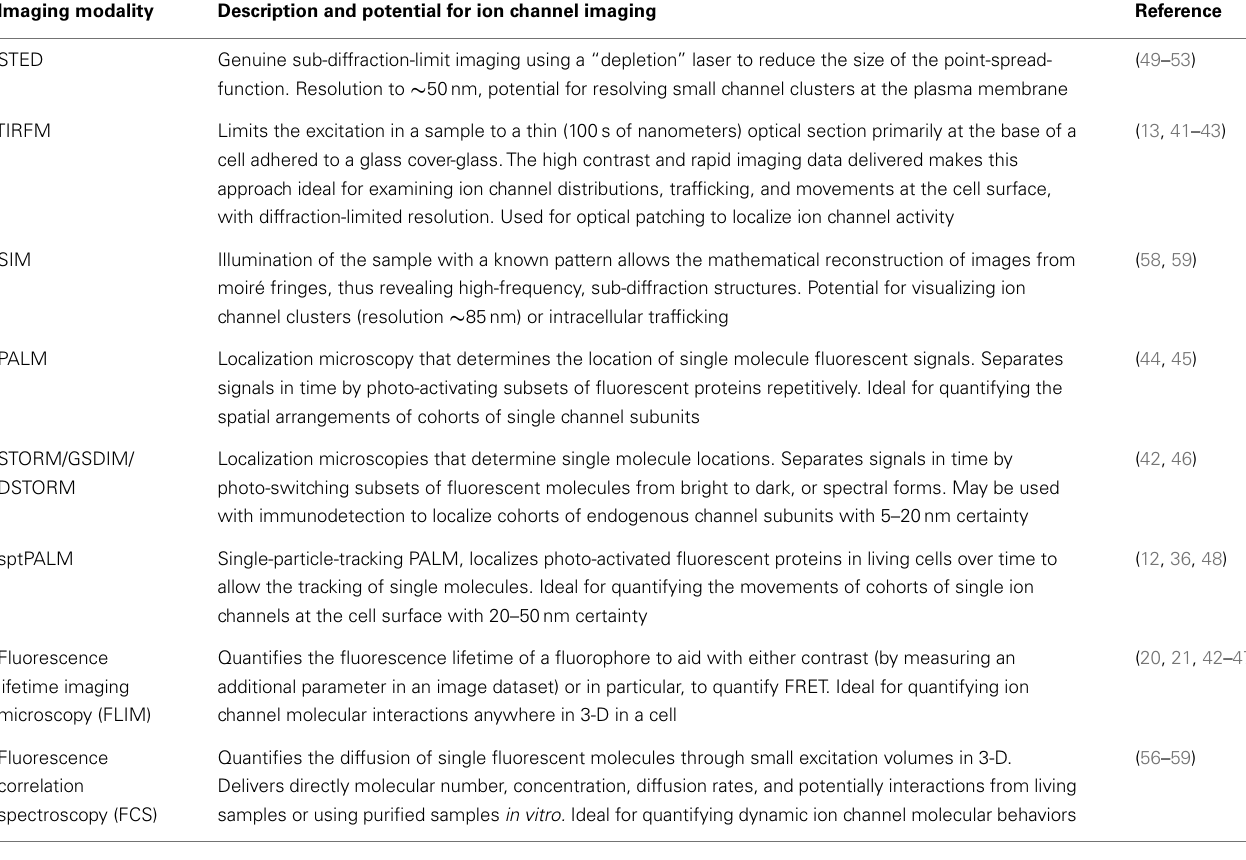
Table 2 | Summary of available super-resolution microscopy and spectroscopic approaches and their potential for ion channel